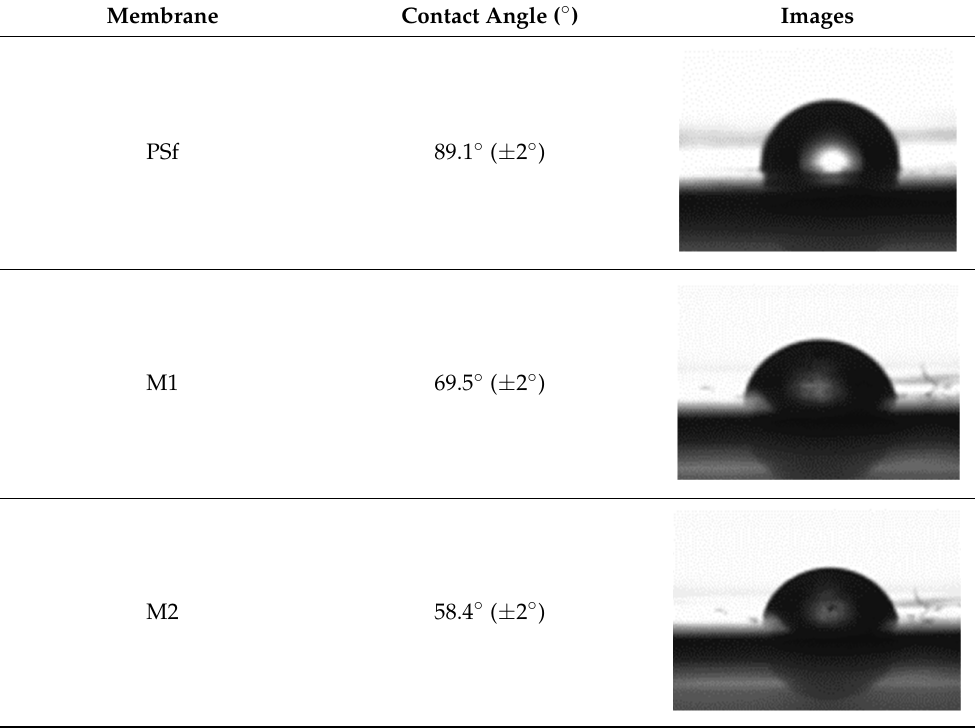
Figure 4. FE-SEM images of (a) surface view of M1 and (c) surface view of M2 membrane and the cross-section images of (b) M1 membrane and (d) M2 membrane. Table 2. Contact angle measurements of polysulfone and prepared M1, M2 membrane.